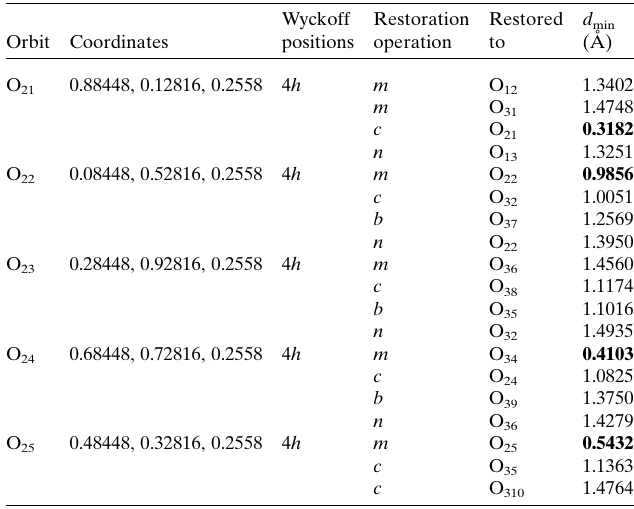
Table 7 Analysis of the split orbits O 2 j stemming from O 2 under H = P (cid:2) 44. Same conventions as in Table 3.